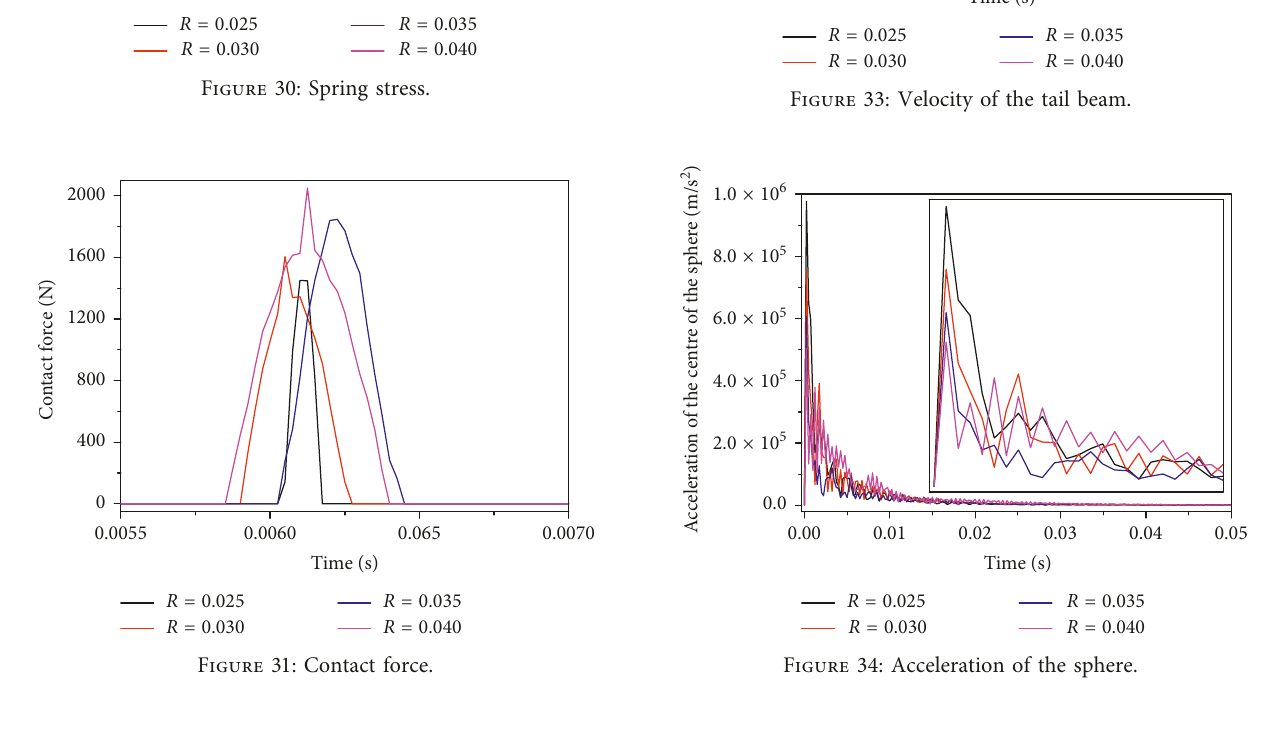
Figure 31: Contact force.